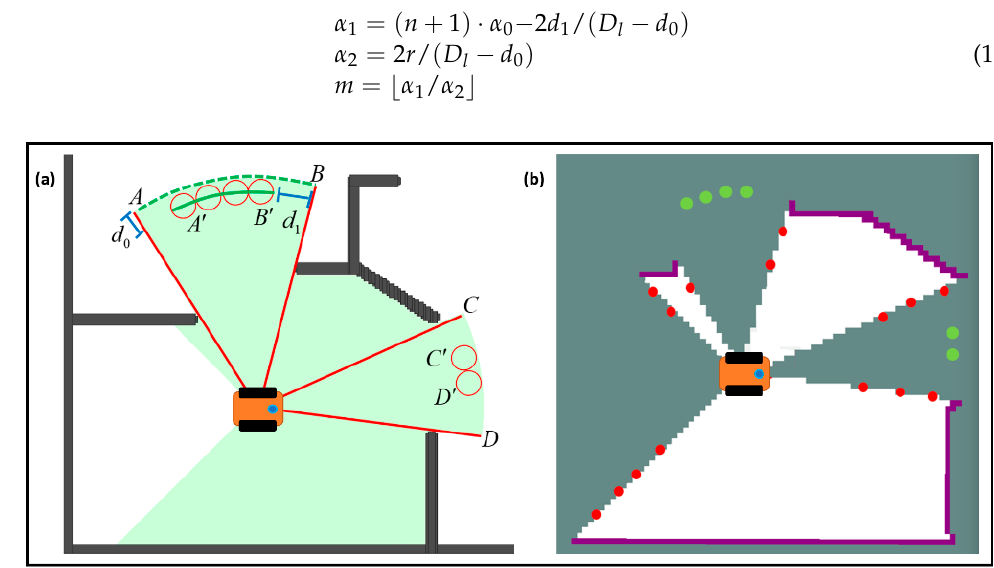
Figure 3. ( a ) Schematic diagram showing the frontiers detection process using lidar data. ( b ) Green dots are the newly added potentially accessible frontiers.